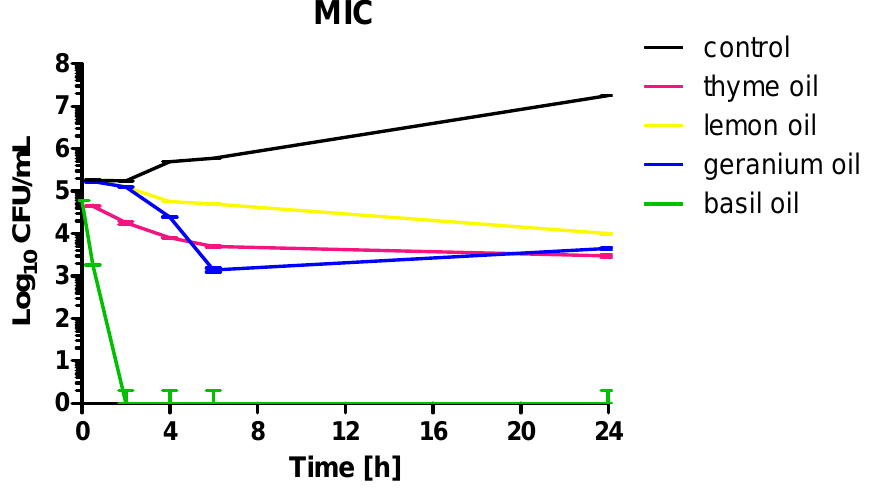
Figure 1. Kinetic of C. albicans ATCC 10231 growth under the influence of EOs in the following concentrations: thyme—0.04%, lemon 0.16%, geranium—0.16%, basil 0.16%.